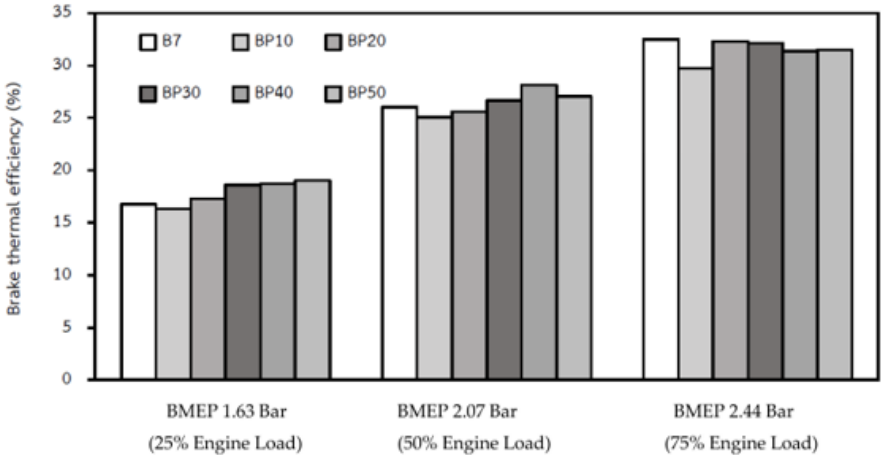
Figure 5. Effects of fuel blends in brake thermal efficiency under various engine loads.